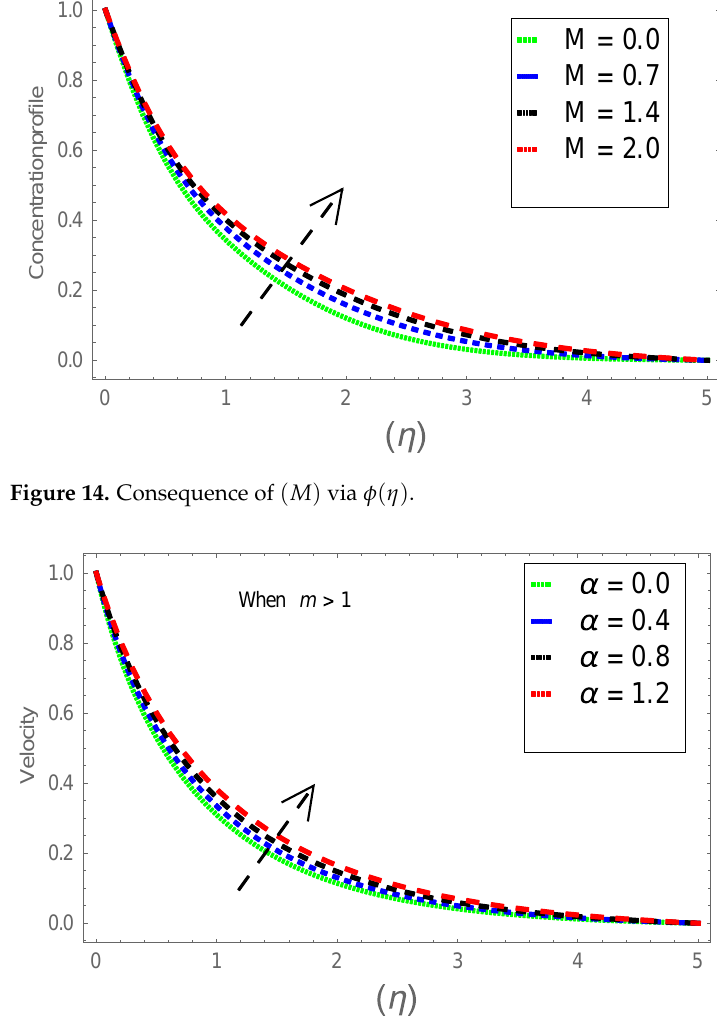
Figure 15. Consequence of ( α ) via f (cid:48) ( η )